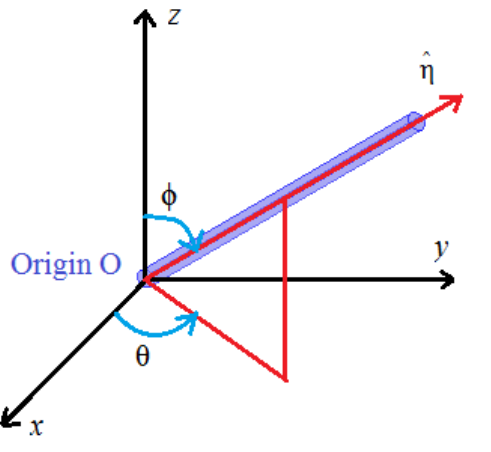
Fig. 2: Co-ordinate system and definitions of θ and φ for an ESF.